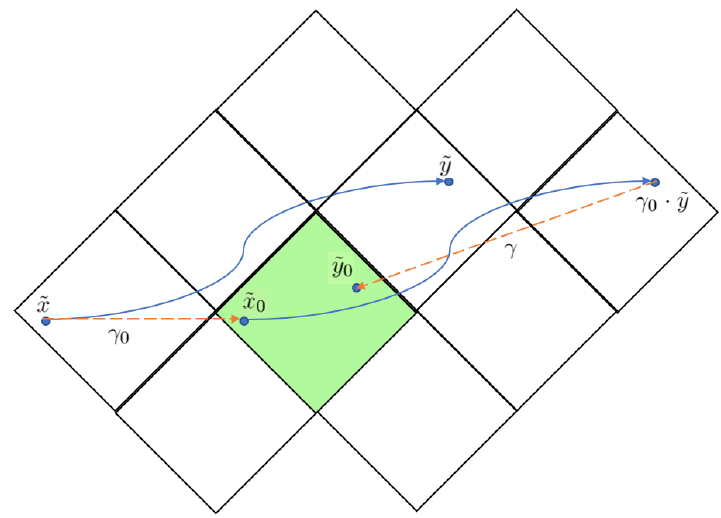
Figure 3. A schematic illustration of the process by which a groupoid element is associated with a voice leading. Diamond-shaped regions depict fundamental domains in the universal orbispace cover X ; green shading indicates the preferred fundamental domain. Solid blue curves are paths; dashed orange lines represent group